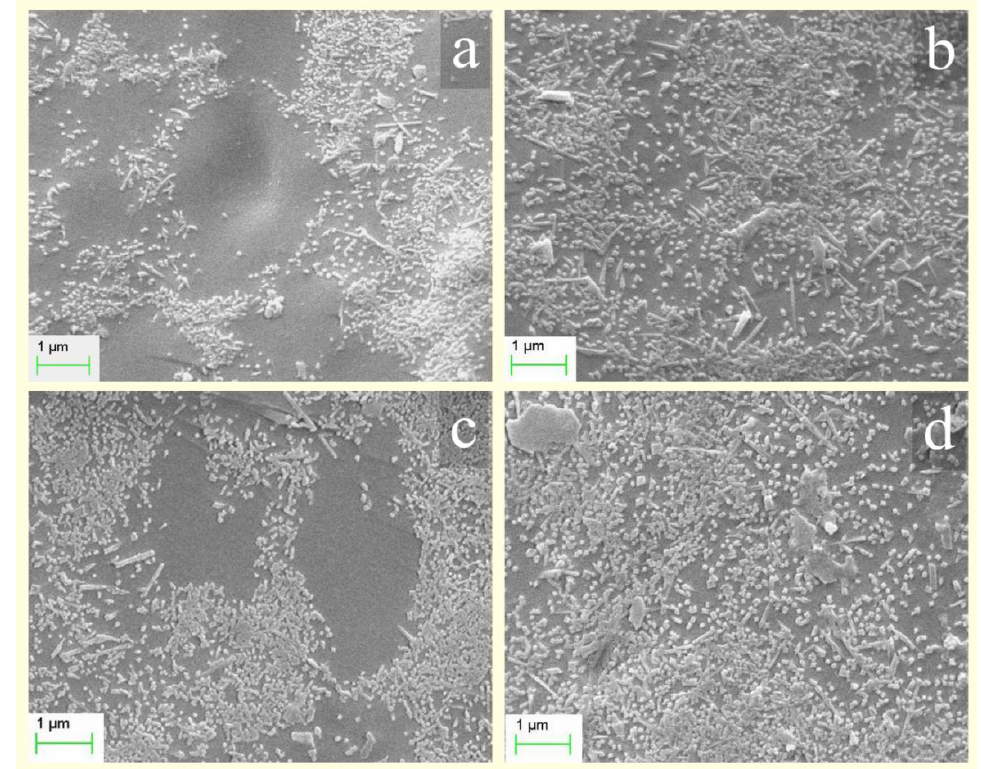
Figure 5. SEM pictures of M1 at ( a ) 1270 °C and ( c ) 1350 °C; SEM pictures of M2 at ( b ) 1270 °C and ( d ) 1350 °C. ( d ) 1350 ◦